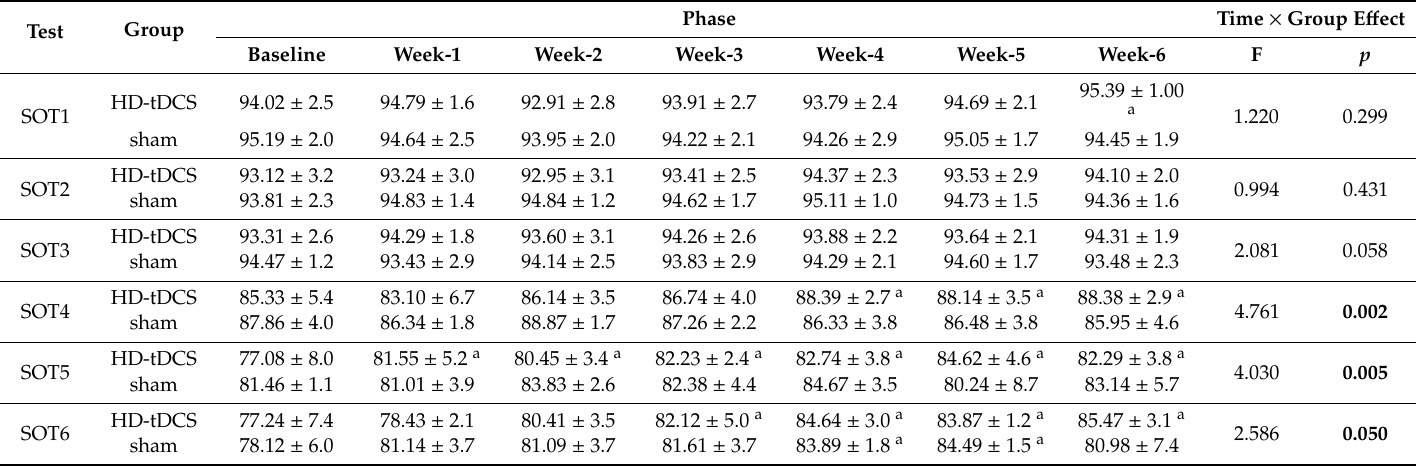
Table 3. Sensory organization test performance (mean ±